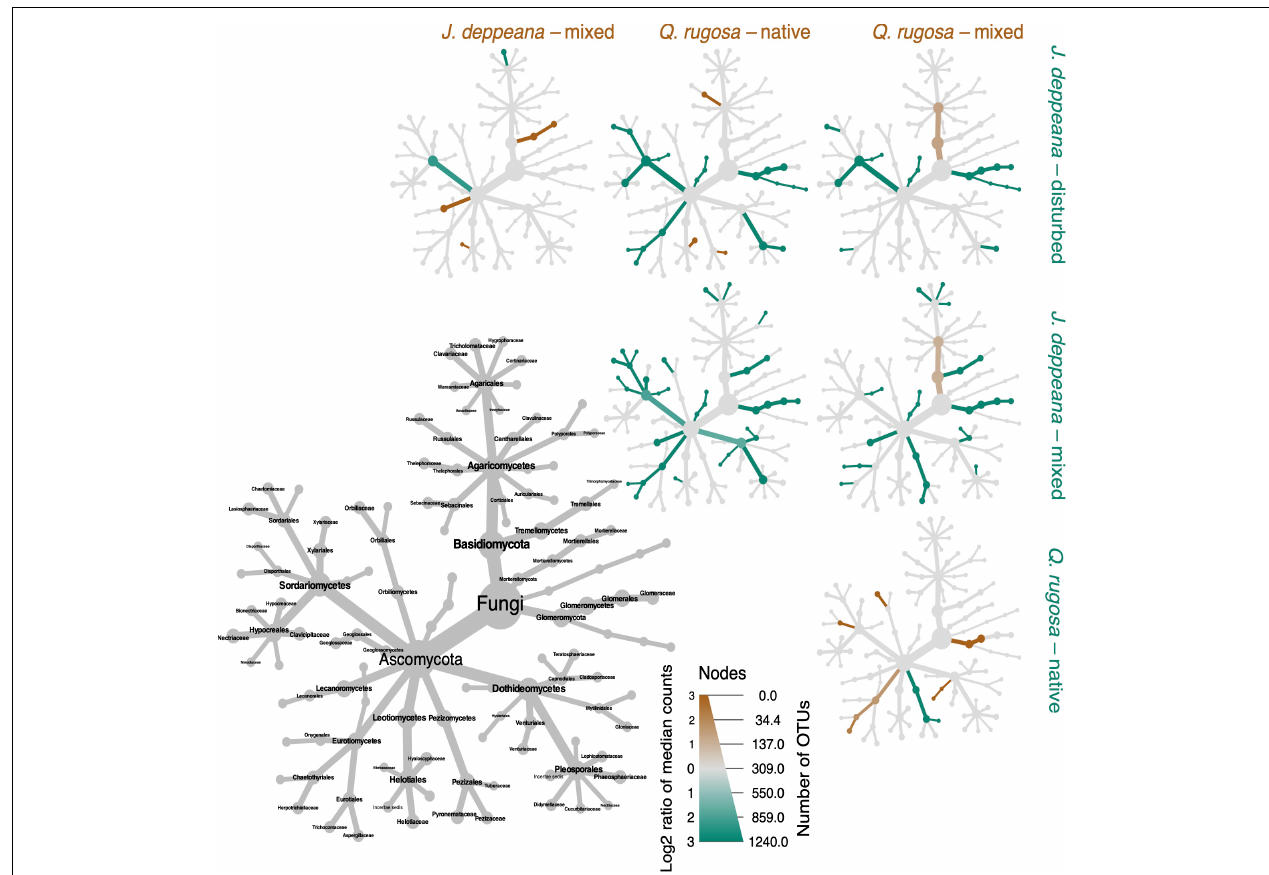
FIGURE 4 | Heat trees illustrating differences in OTU abundance between treatments (host/site combinations) at family level, for taxa with relative abundance higher than 0.1% of total read count per sample. The size of nodes in the large gray cladogram depicts the number of taxa identified at each taxonomic level. The smaller cladograms represent pairwise comparisons between treatments, with orange-brown nodes indicating a significantly higher abundance in the treatment displayed horizontally (based on Wilcox rank-sum tests with Benjamini–Hochberg corrections for multiple testing), while blue-green nodes indicate a significantly higher abundance in the treatment shown